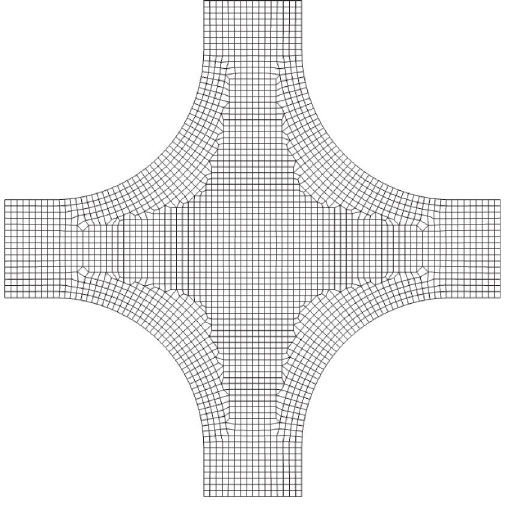
Figure 3: Cross-section view of grid level 3.